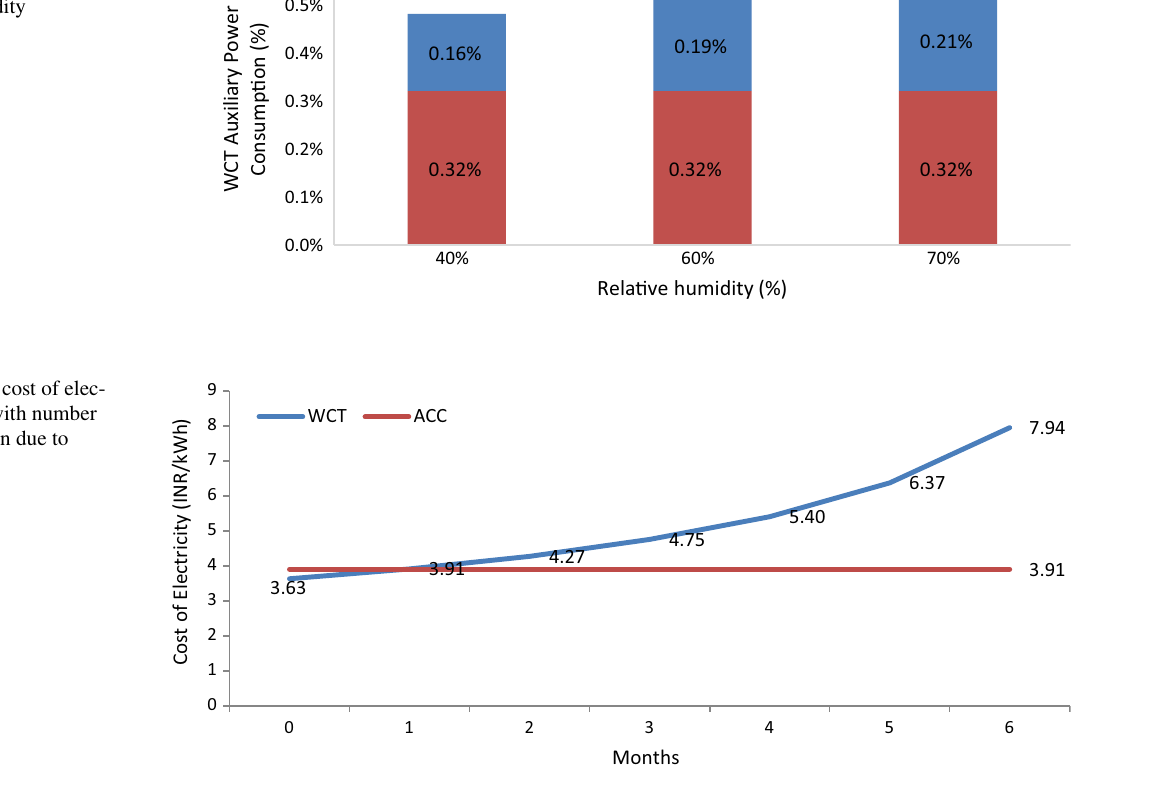
Fig. 5 Variation in auxiliary power consumption of WCT with relative humidity